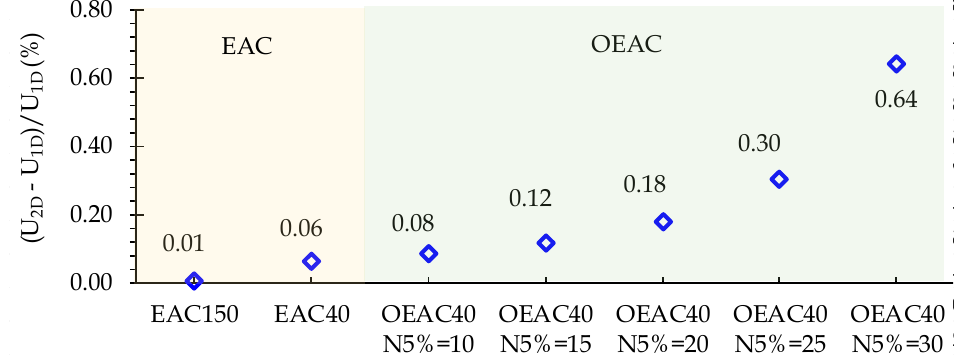
Figure 10. Steady-state velocity profile error for standard and optimized meshes.